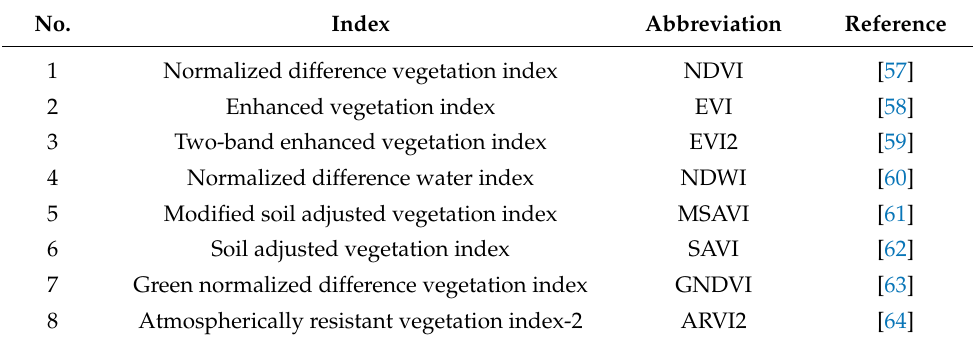
Table 3. Vegetation indices used in the present study.